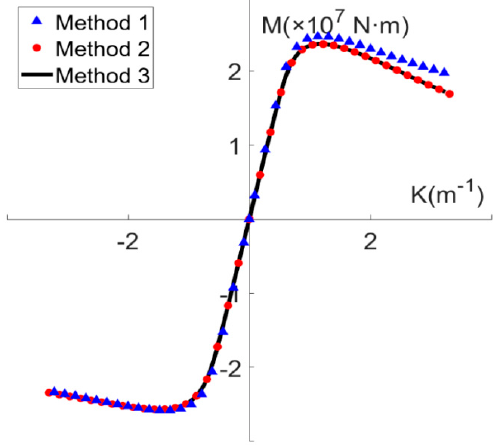
Figure 9. Bending moment in CASE 2.